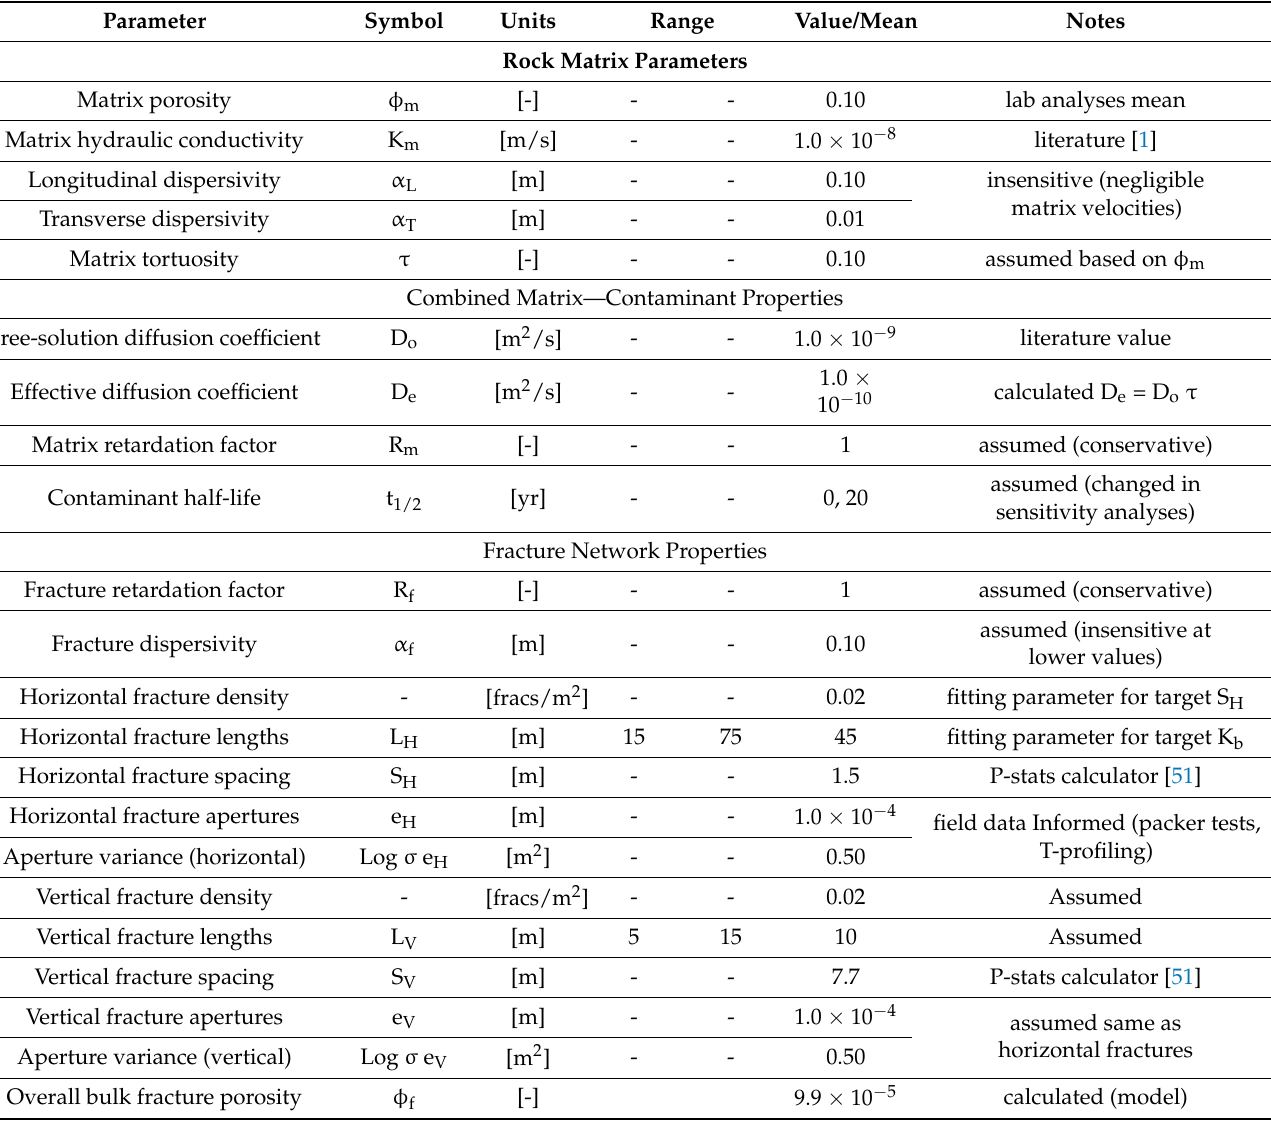
Table 1. Parameters applied in DFM model